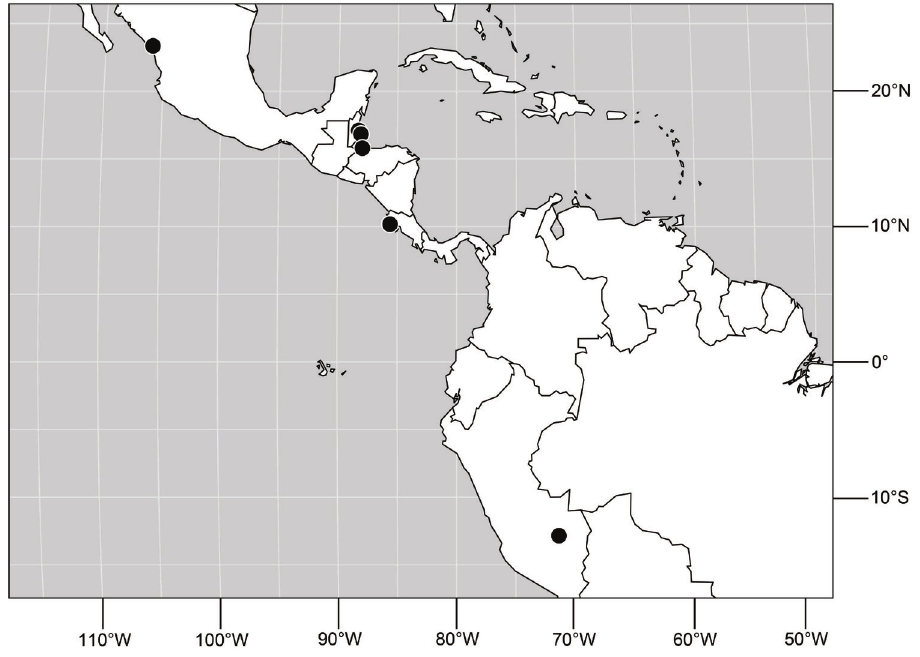
Figure 43. Distribution of Hydrochasma sinuatum sp.